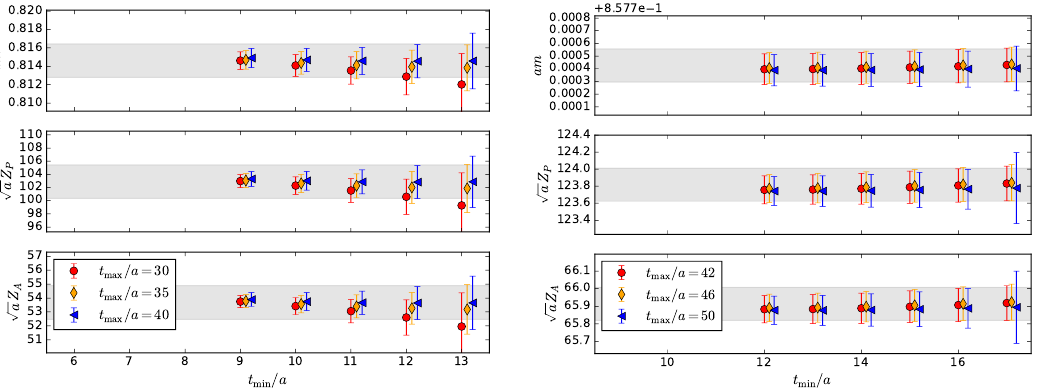
Figure 3 . Variation of the time slices included in the correlation function (cid:12)ts for a heavy-light (left) and heavy-strange (right) meson on the M0 ensemble. The grey error band shows the result of the conservatively chosen (cid:12)t with t=a 2 [12 ; 41) (left) and t=a 2 [15 ; 44)